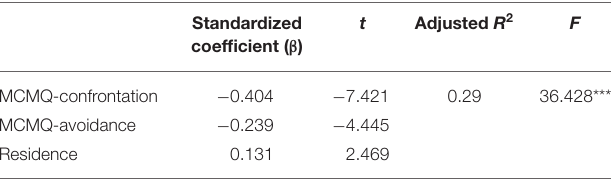
TABLE 3 | Stepwise regression analysis of factors influencing vaccine hesitancy in patients with